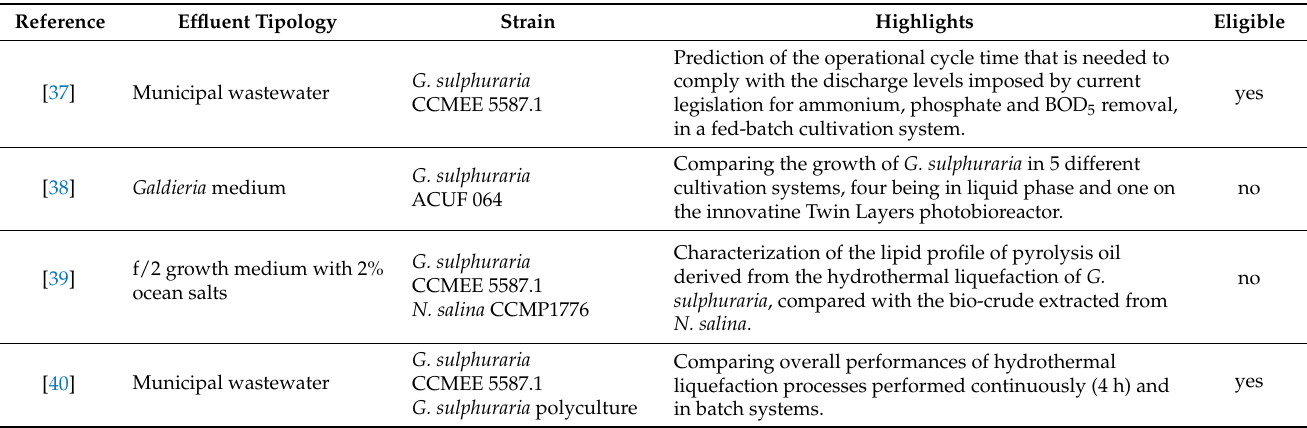
Table 1. Scientific articles provided by Scopus platform and associated to the words “ Galdieria ” and “wastewater”. Articles included into the study (“eligible”) are the ones involving municipal wastewater as